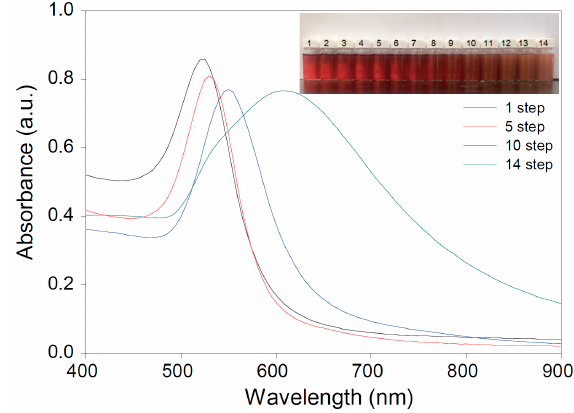
Figure 2. UV-vis spectra of dispersions of different-sized AuNPs. Inset is photograph of AuNP dispersions obtained from different seeded growth steps of 1 to 14.